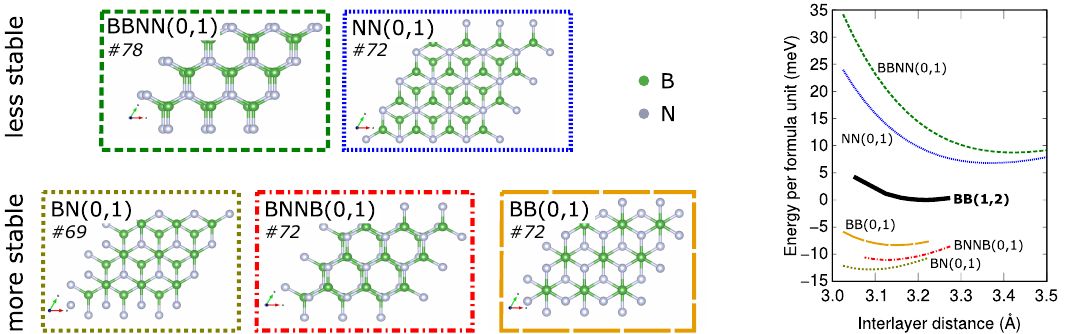
Figure 11: The five hexagonal stackings in untwisted bilayers, their symmetry layer group (#) and their stability curves with respect to the BB(1,2) twisted